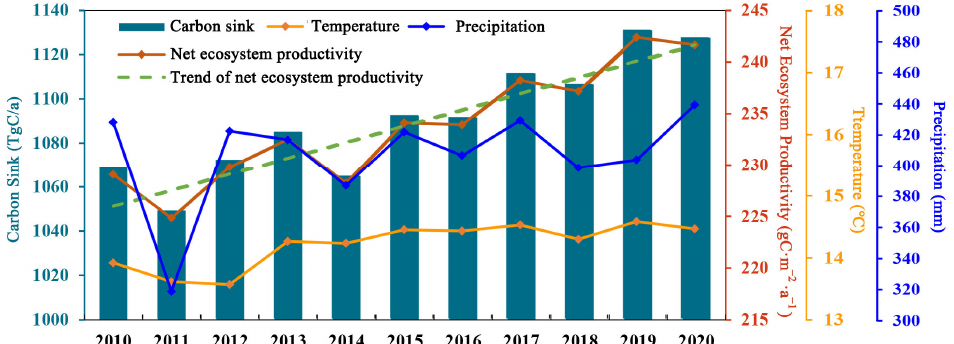
Figure 7. Trends of annual average NEP and CS in CES.